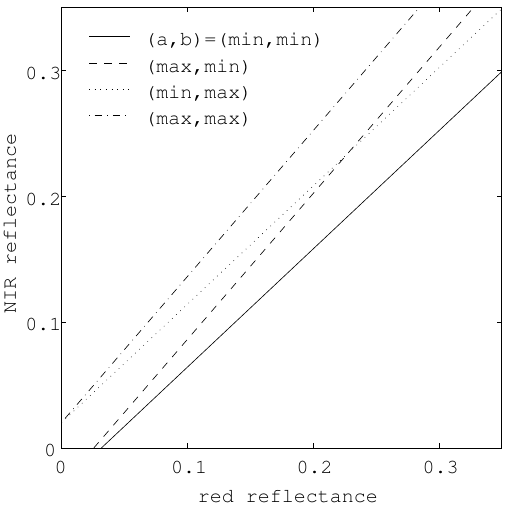
Figure 2. Four extreme soil lines determined from the soil samples in Table